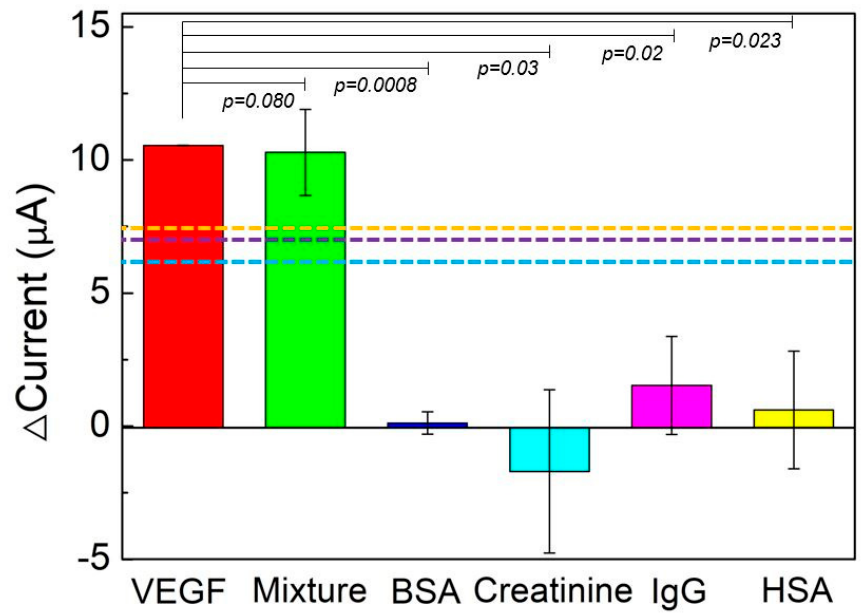
Figure 10. Results of specificity test of Au/ZnPP/Avastin/BSA electrode (w/LT) ( n = 3). The blue, purple, and orange dotted lines indicate the cut-off levels for breast [5], liver [39], and colorectal cancers [40], respectively.